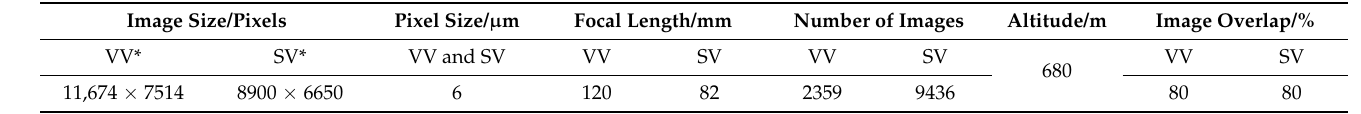
Table 2. Details of the oblique image